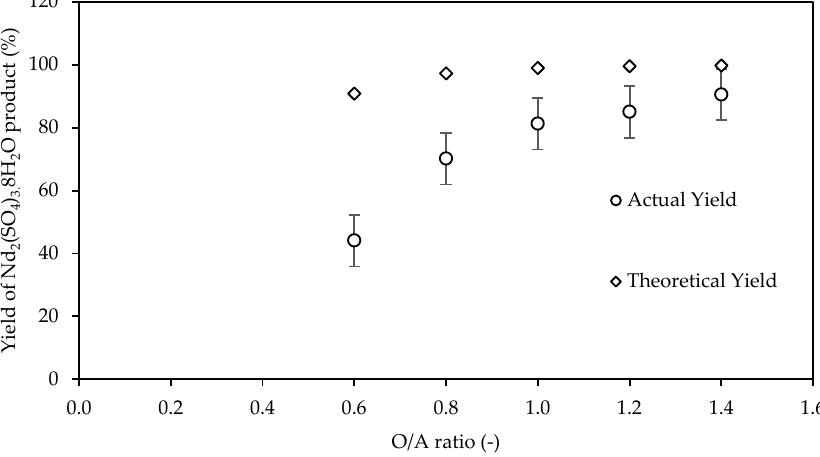
Figure 3. Yield of Nd 2 (SO 4 ) 3 .8H 2 O crystals at different O/A ratios. Increasing the amount of ethanol from an O/A ratio of 0.6 to 1.4 increased the actual yield of Nd 2 (SO 4 ) 3 .8H 2 O. This was due to the reduction in the solubility of neodymium sulphate, which caused its crystallization. A further reduction in solubility occurred as the amount of ethanol increased, causing more Nd 2 (SO 4 ) 3 .8H 2 O to crystallize.